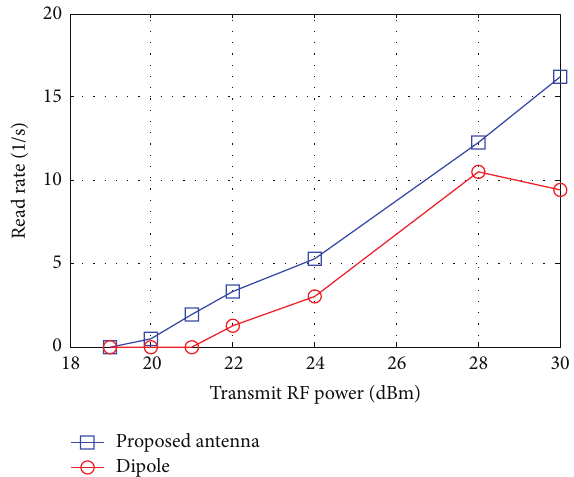
Figure 19: Measured read rates versus transmitted power at a fixed distance of 1 meter in the anechoic box without a human body close by.